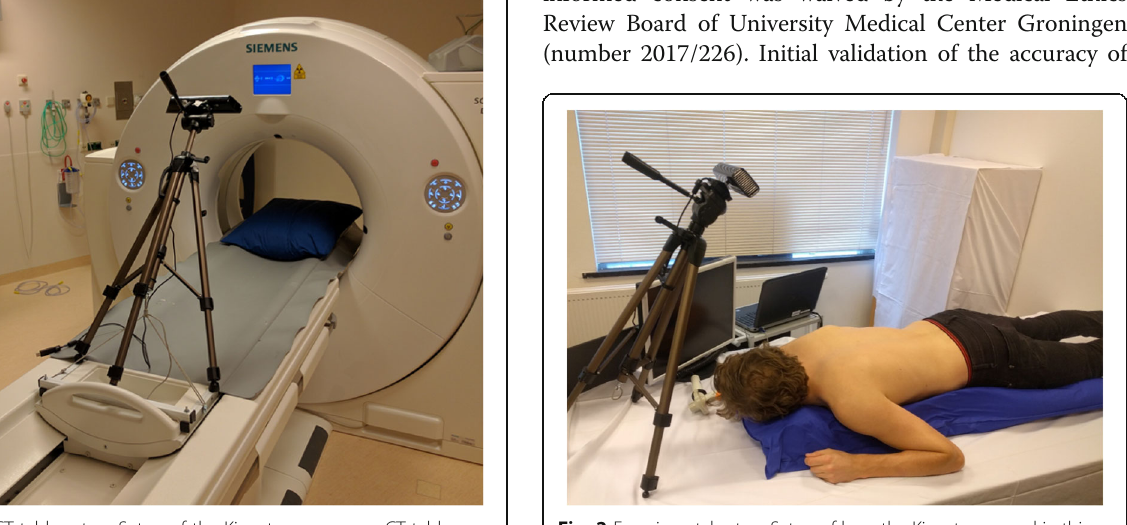
Fig. 1 CT table setup. Setup of the Kinect camera on a CT table, positioned with its field of view into the gantry. The tablet can provide visual biofeedback to patient and operator